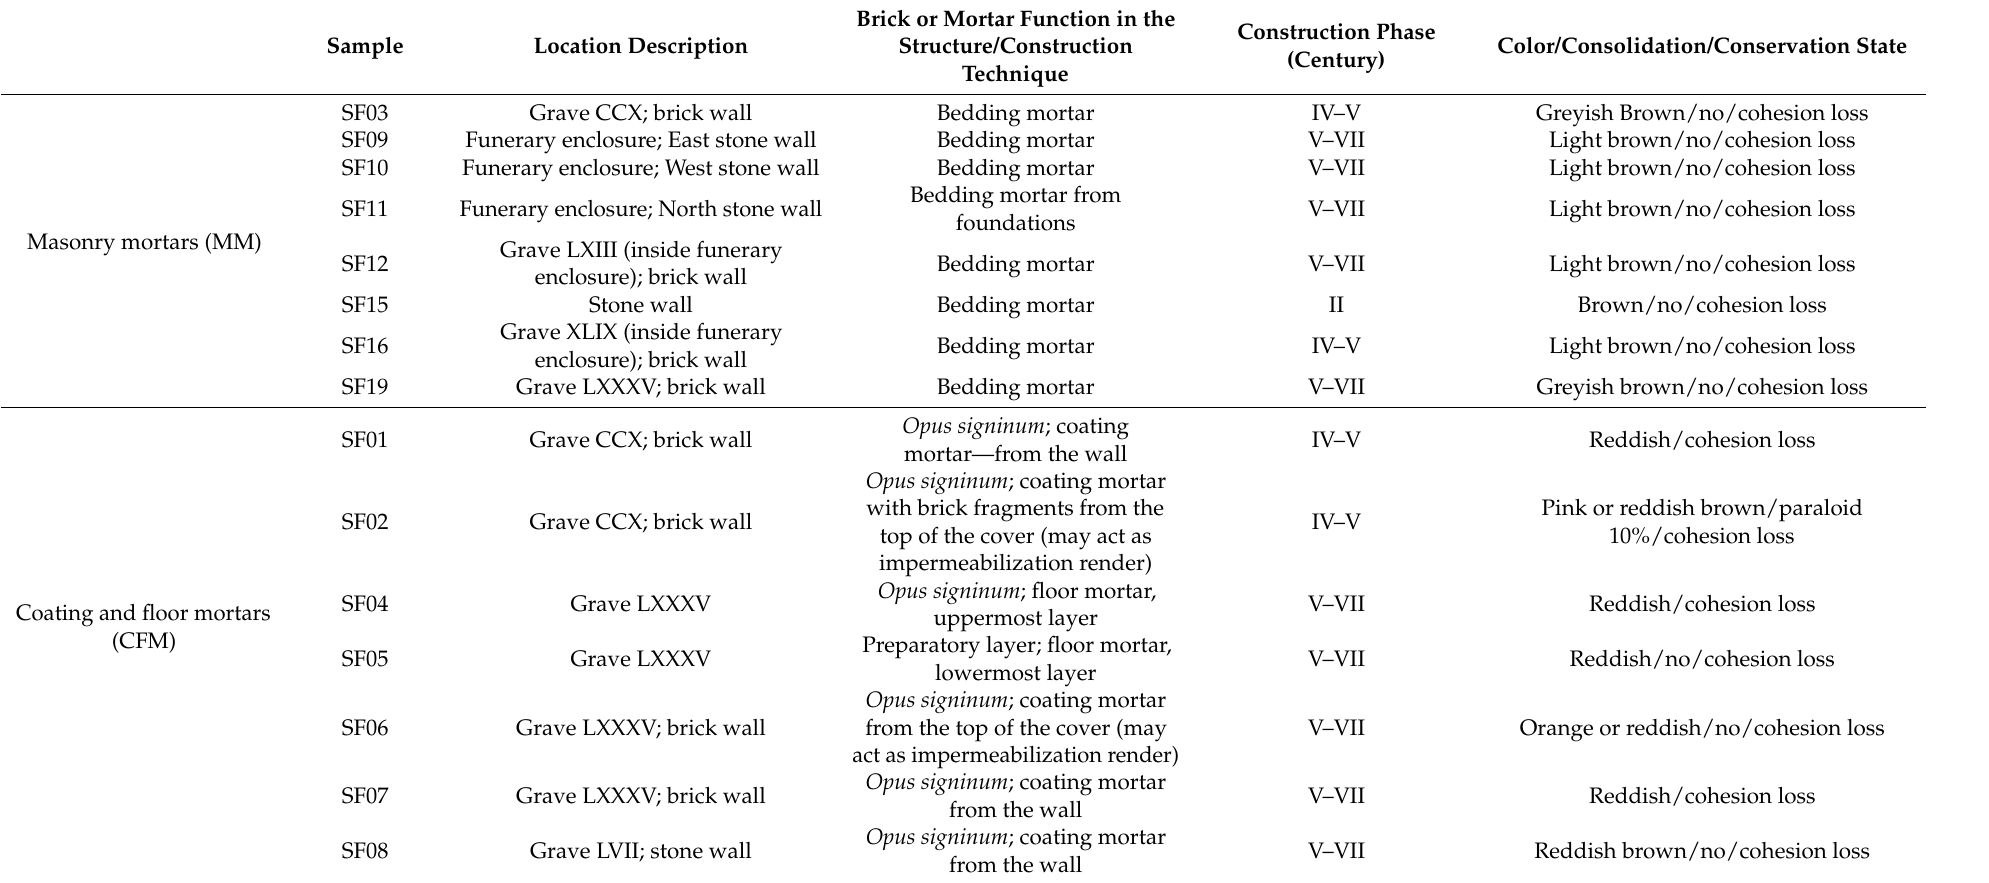
Table 1. Description of the mortars and bricks samples from the funerary